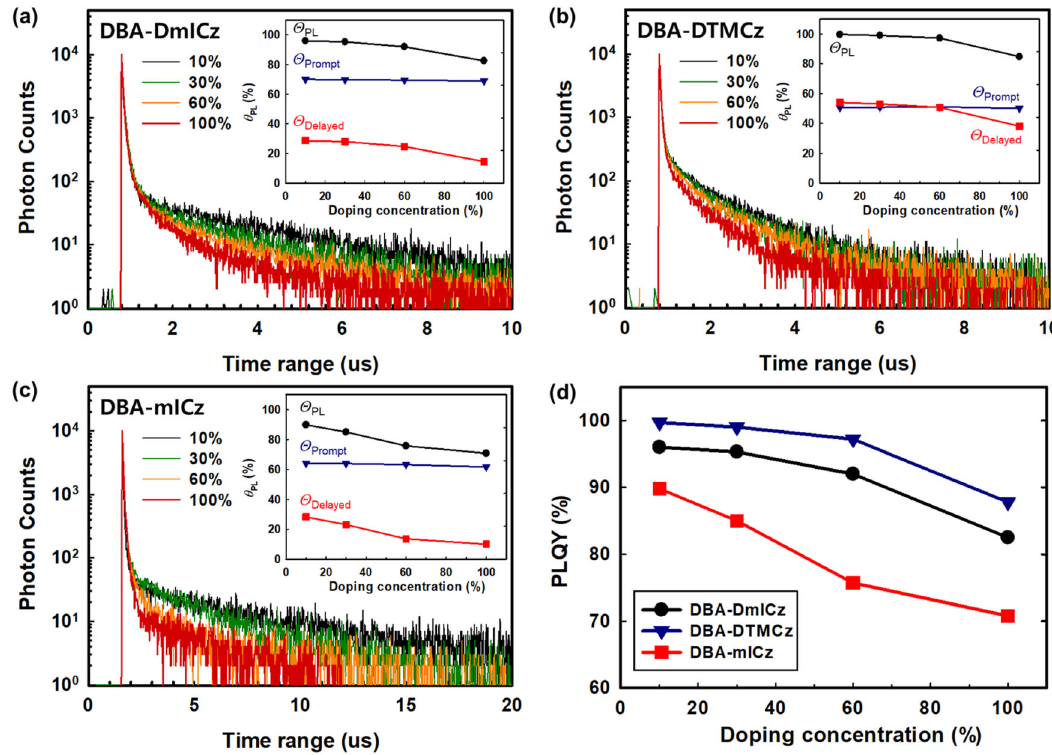
Fig.7|TransientPLandPLQY. TRPLdecaycurvesandPLQYvariation a DBA-DmICz, b DBA-DTMCz,and c DBA-mICzdependingonthedopingconcentration. d Theplot of PLQY depends on the doping